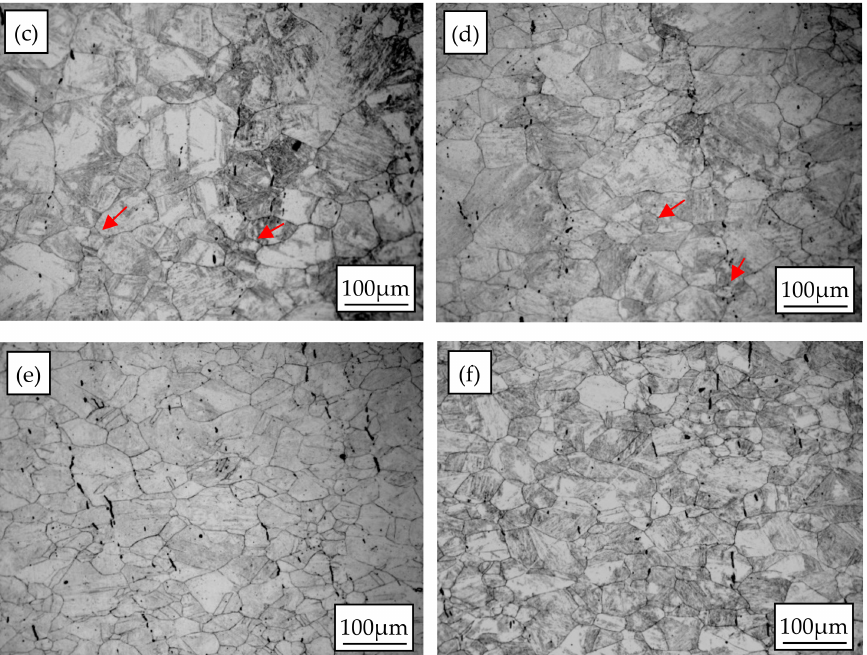
Figure 5. Microstructural evolution of experimental steel at deformation temperature of 900 ◦ C and different interruption times: ( a ) 1 s, ( b ) 5 s, ( c ) 10 s, ( d ) 20 s, ( e ) 100 s, and ( f ) 400